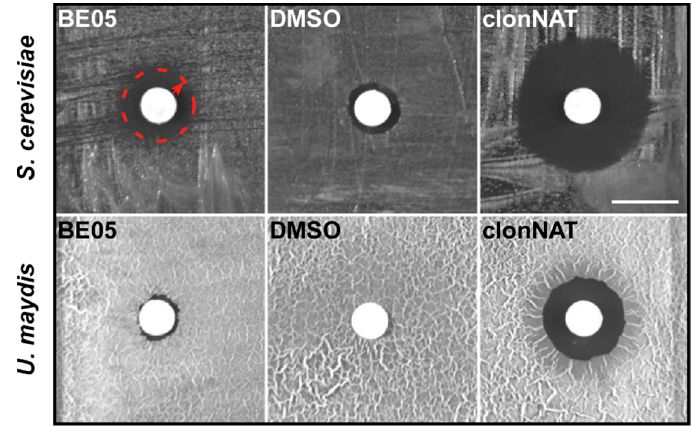
Figure 1. Bioactivity test of the basidiomycete ethyl acetate crude extract BE05 against S. cerevisiae and U. maydis . In total, 100 µg of crude extract was dissolved in DMSO to impregnate a filter paper disk centrally placed on each agar plate. DMSO was used instead of the crude extract as negative control and 200 µg of clonNAT dissolved in ddH 2 O was used as positive control. The scale bar represents 1 cm. Three independent biological experiments (n = 3) were carried out. The biotesting with extract BE05 (left part of the panel) yielded a zone of growth inhibition (halo, dashed red circle with arrow) with S. cerevisiae, while resulting in minimal growth inhibition with U. maydis .